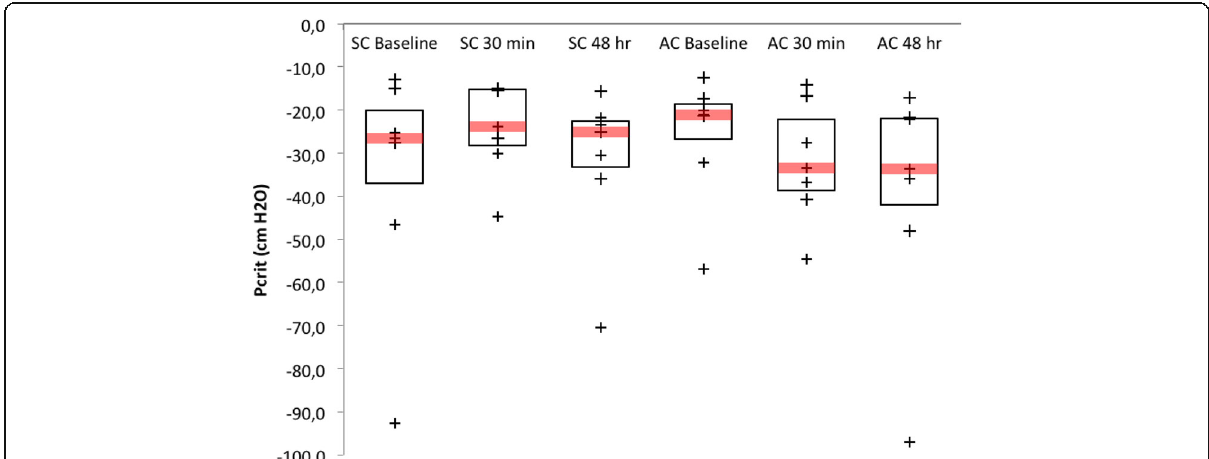
Fig. 3 Upper airway critical closing pressure (Pcrit) before, 30 min and 48 h after sham manipulation (SM) ( left ) and active manipulation (AM) ( right ) of the sphenopalatine ganglion. The box represents the Q1-Q3 interquartile range, in which Q1 represents the first quartile and Q3 represents the third quartile. The bar in the box represents the median. The endpoint of the lower whisker is the minimum value higher than the lower limit defined by the following formula: Q1-1.5* (Q3-Q1). The endpoint of the upper whisker is the maximum value lower than the upper limit defined by the following formula: Q3+1.5* (Q3-Q1). + represent individual